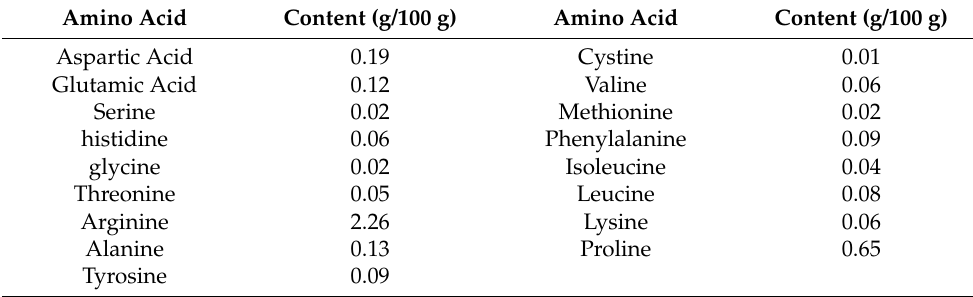
Table 1. The Amino Acid Composition of Ginseng Oligopeptides (GOPs). Amino